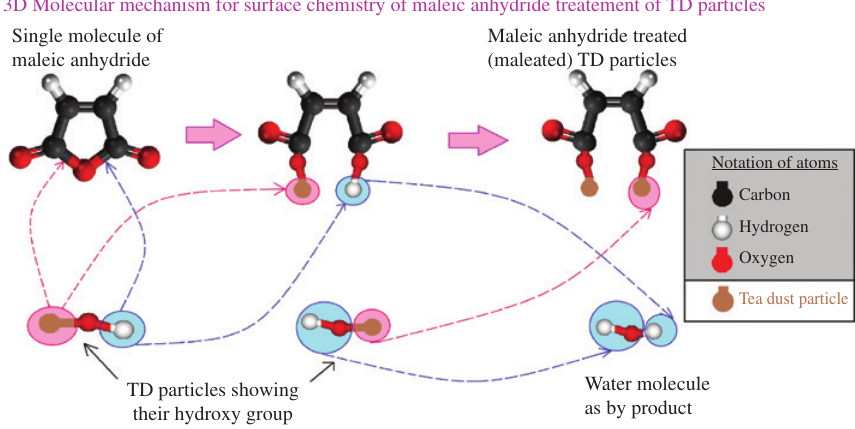
Figure 1: Surface modification of TD particles using